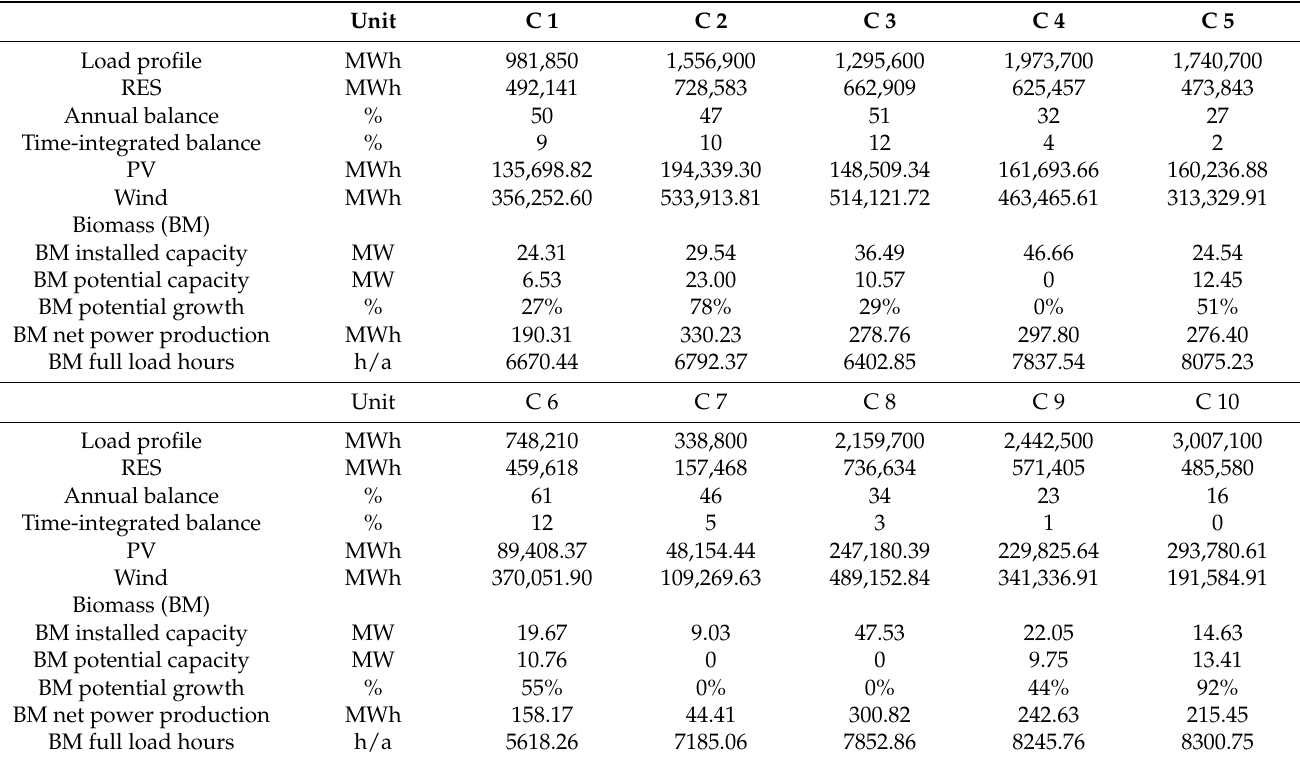
Table 8. RES modelling results for each